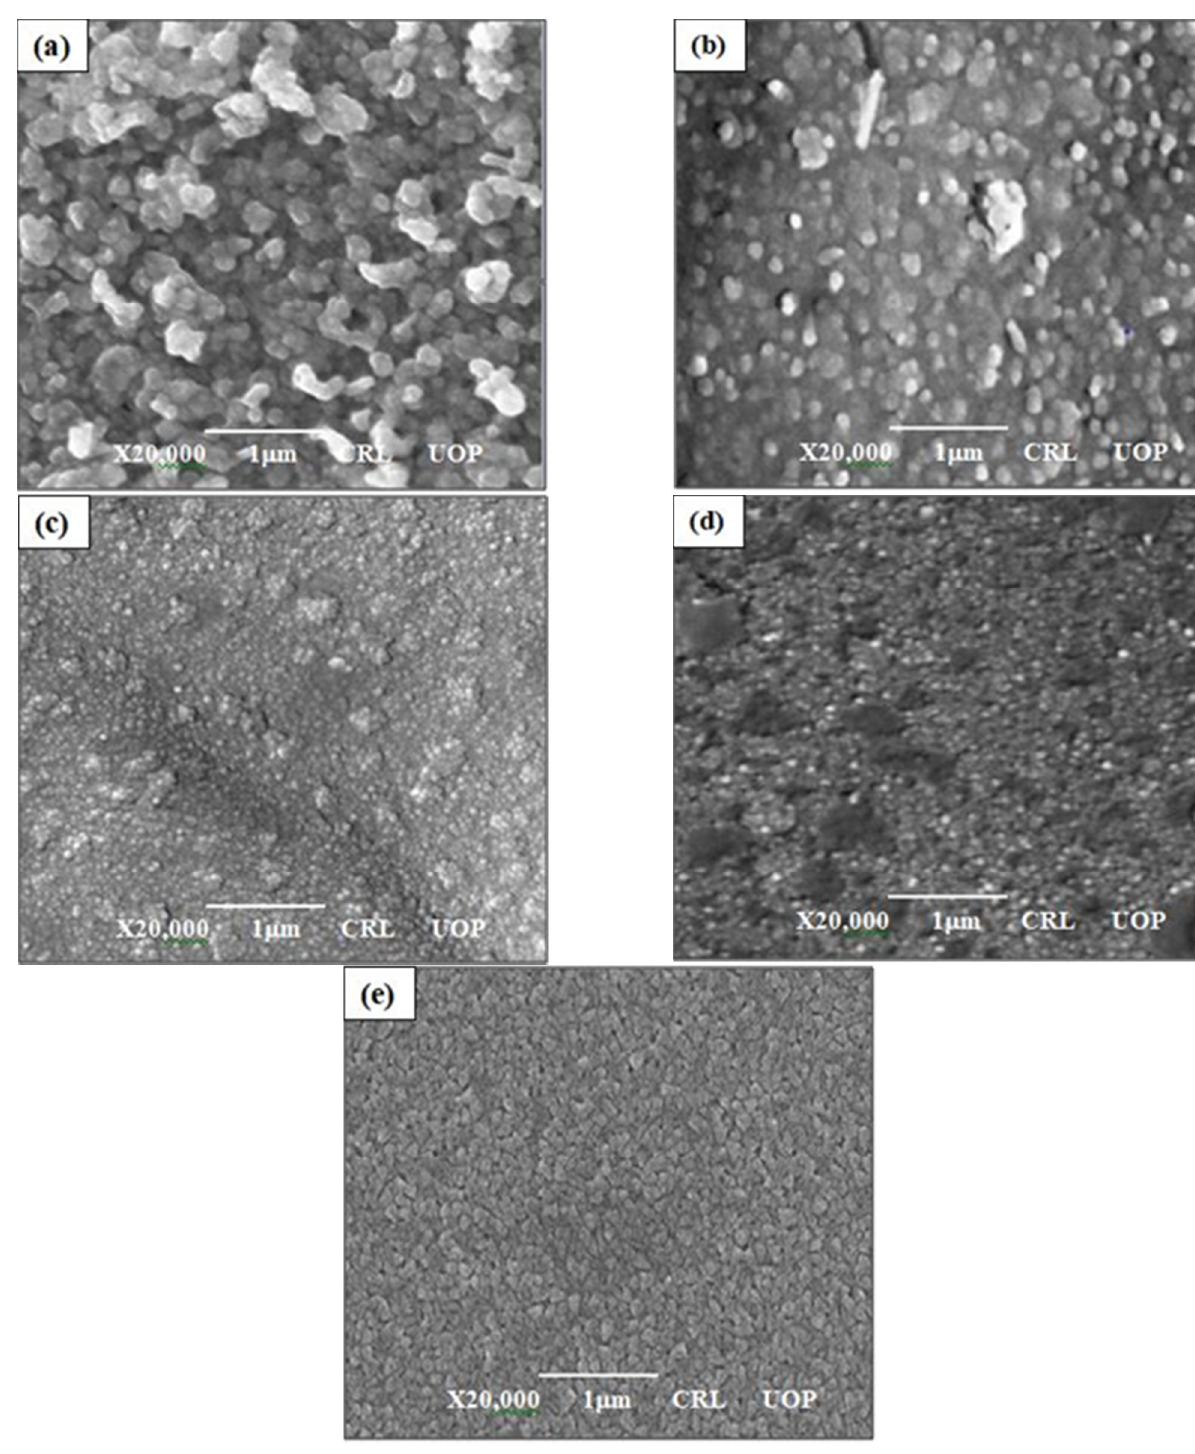
Figure 3. SEM images: ( a ) CdO; ( b ) Cd 0.75 Mg 0.25 O; ( c ) Cd 0.5 Mg 0.5 O; ( d ) Cd 0.25 Mg 0.75 O; ( e ) MgO annealed thin films. The amount of Mg deposited on the CdMgO thin films is revealed by EDX as shown in Figure 4a–d. With the increase in MgO evaporation, the concentration of Mg content in the films increased. There are some peaks of silicon which may have appeared due to the glass substrate. The atomic percentage composition of elements is shown in Table 2.